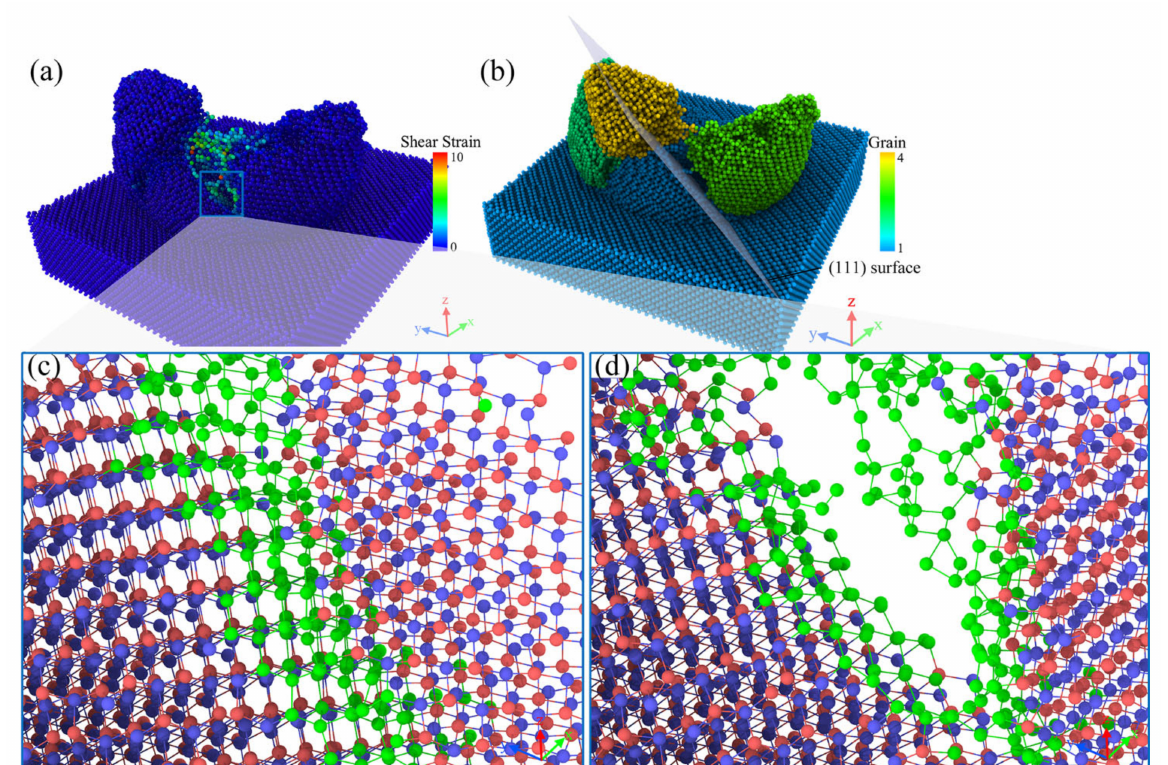
Figure 3. Screenshots of the extension of the cracks. ( a ) shows the distribution of atomic shear strain at 12 nm plowing distance, at which point ( b ) shows the workpiece in a polycrystalline state, with the translucent (111) fracture surface being the dissociated surface of the GaAs. ( c , d ) show the evolution of the atomic structure of the crack formation process at 11 nm and 12 nm plowing distances,